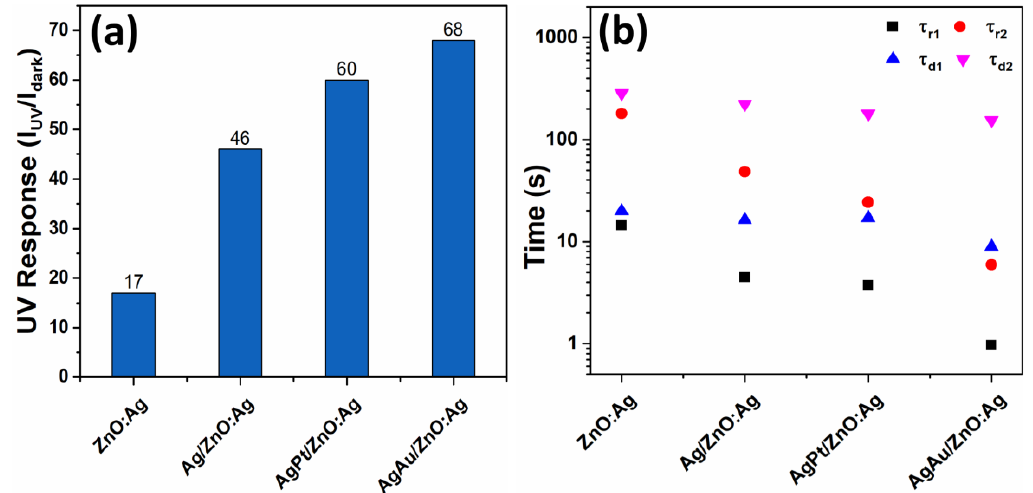
Figure 4. (a) UV response for ZnO:Ag; Ag/ZnO:Ag; AgPt/ZnO:Ag and AgAu/ZnO:Ag nanostructured films. (b) The time constants for rising and decaying